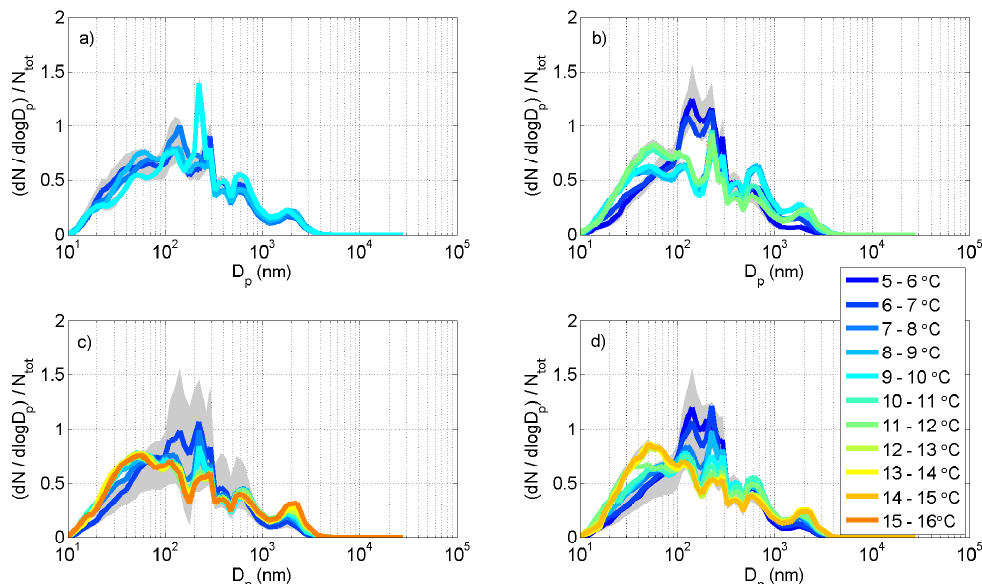
Fig. 10. Normalized number size distributions for summer experiments resulting from bubble bursting of (a) deep fjord water, (b) water sampled close to the glacier, (c) water sampled at the fjord mouth and (d) water sampled at the middle of the fjord. Grey shaded areas represent the interquartile range for the lowest and highest water temperature range. The same grey shade is used for both temperature ranges and indicates if there is an obvious difference between the particle number concentrations of different sizes of the lowest and highest water temperature.